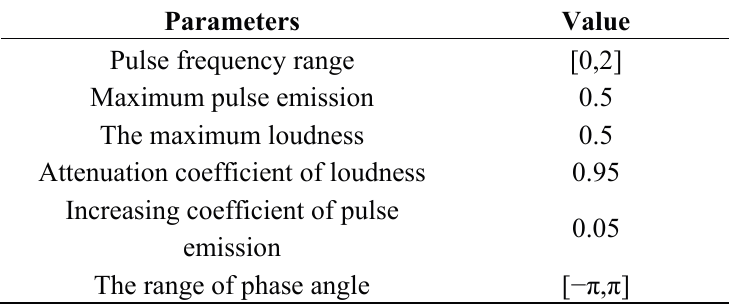
Table 2. The parameters setting of quantum bat algorithm (QBA).